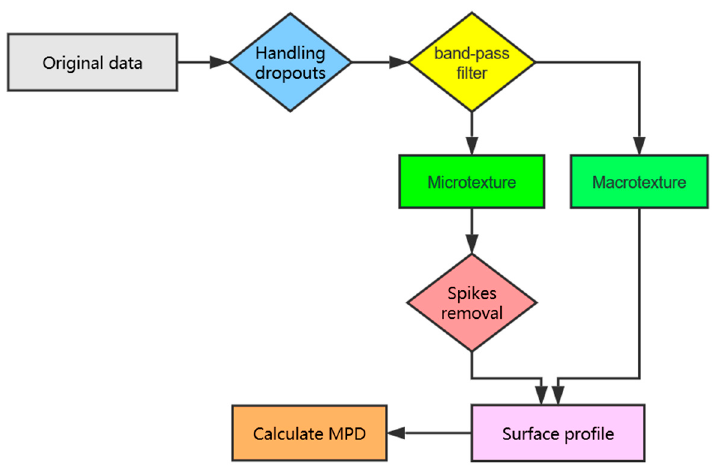
Figure 1. Flow chart of implementation procedures.